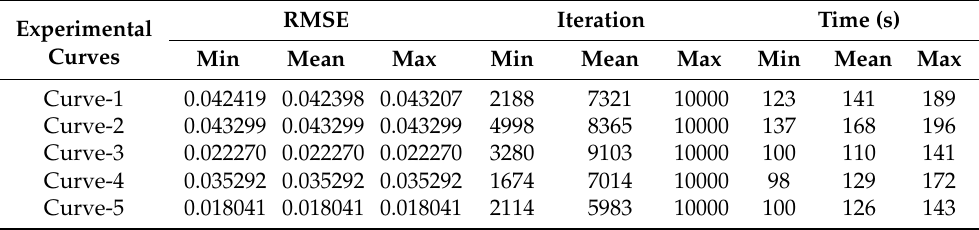
Table 13. JKM330P-72 DDM PV module statistical results for all respective